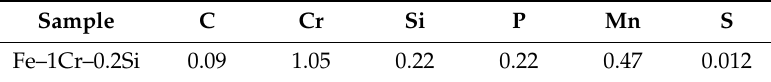
Table 1. Composition of the tested steels